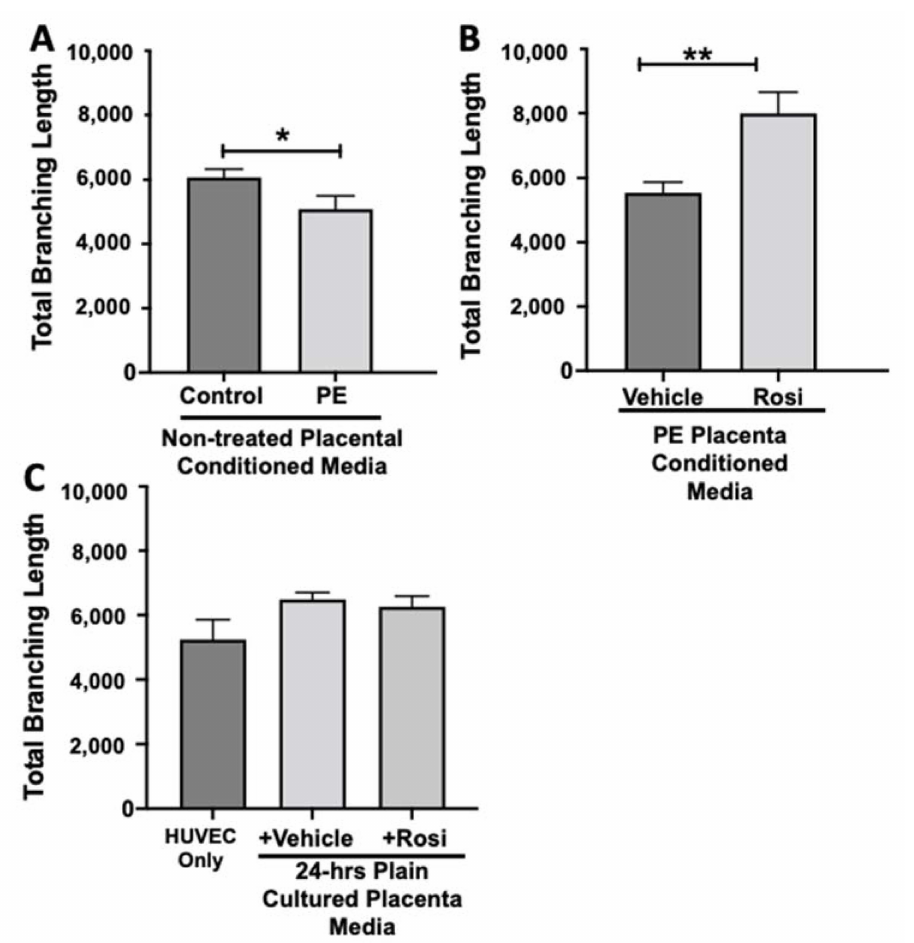
Figure 12. There is a reduction of the total branching length present in HUVECs cultured with preeclamptic placental conditioned media, but this was significantly increased after culture with Rosiglitazone-treated preeclamptic placentas. HUVECs were cultured with conditioned media on matrigel, and the total branching length was calculated by the Image J Angiogenesis Analyzer tool (30). Conditioned media from preeclamptic (PE) placentas show significantly reduced total branching length as compared to healthy control placentas ( A , n = 6). Conditioned media from Rosiglitazone (Rosi)-treated PE placentas led to a significant increase in the total branching length present in the HUVECs compared to the conditioned media from the vehicle-treated PE placentas ( B , n = 6). Rosiglitazone and vehicle were cultured in placental media without any tissues for 24 h along